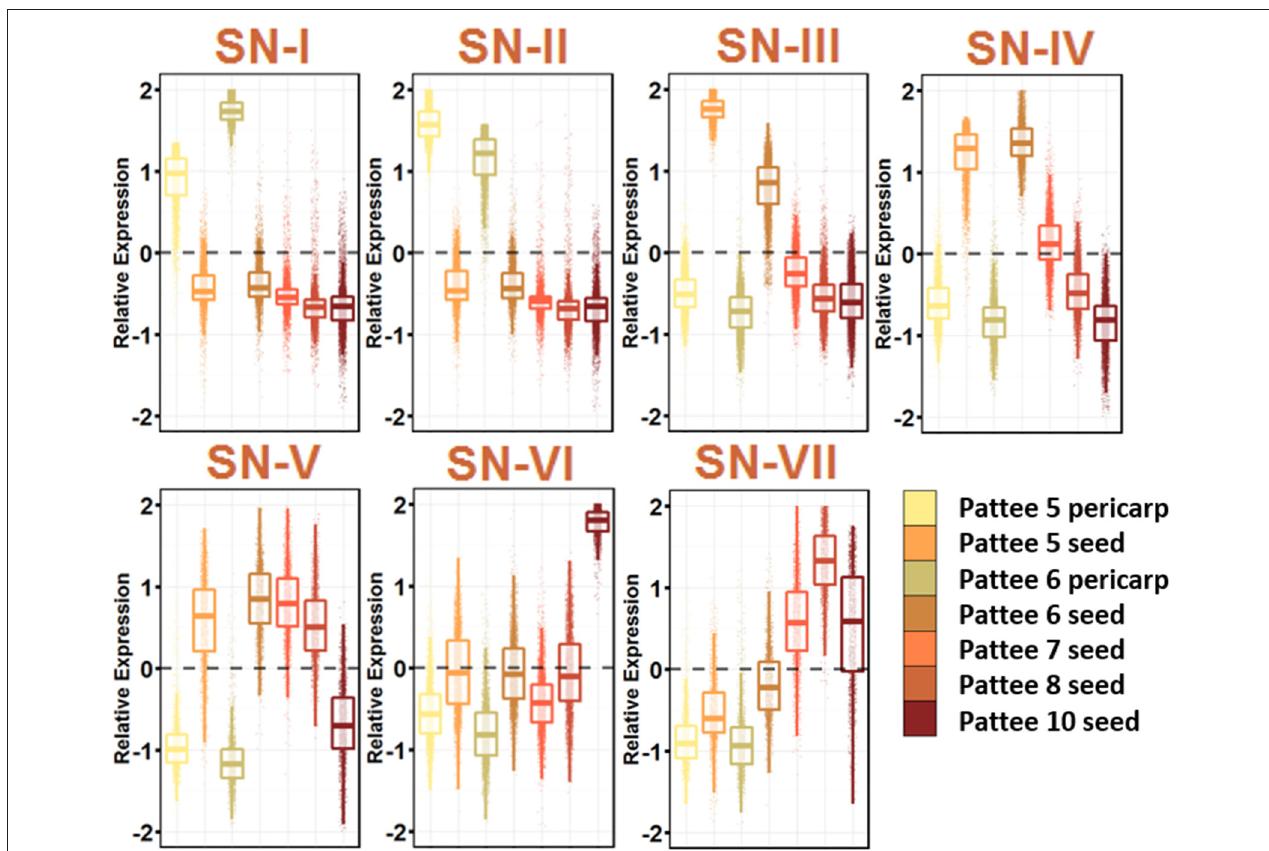
FIGURE 4 | Seed Development Gene Networks (SN). Relative expression is Z-score transformed FPKM. Pattee refers to the stages of peanut development established in (Pattee et al., 1974). Plots are jigger boxplots with every gene’s normalized gene expression shown in the plot. Boxplot is traditional boxplot with median, and upper and lower quartiles. Each tissue is colored as in key to right in the same order.